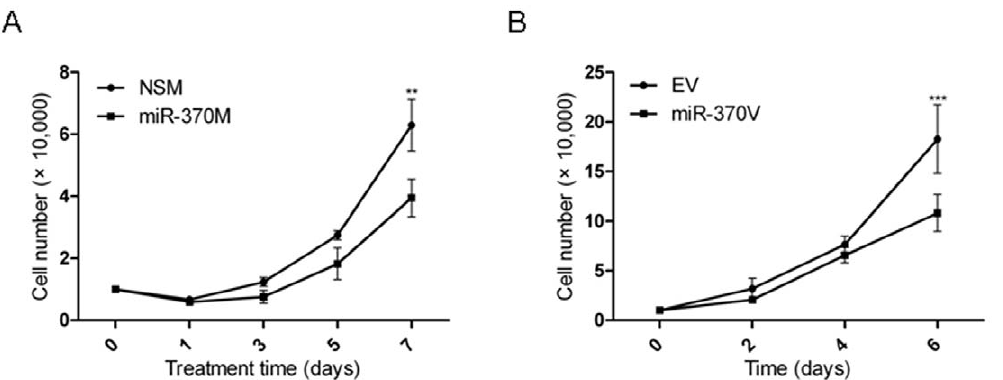
Figure 6. miR-370 induces growth retardation. A. HuCCT1 malignant cholangiocytes display decreased growth upon reinforcement of miR-370 expression. X-axis – HuCCT1 cells counted at day 1, 3, 5 and 7 after transfection with miR-370M, or NSM, respectively. Y-axis – cell counts 6 10 4 of HuCCT1 cells transfected with miR-370 mimic (miR-370M, black squares) or NSM (black circles). B. HuCCT1 malignant cholangiocytes display decreased growth upon modest miR-370 upregulation through infection with MIEG3-miR-370. X-axis – HuCCT1 cells counted at days 2, 4 and 6 after plating of MIEG3-miR-370 (miR-370V) HuCCT1 cells or MIEG3-EV (EV) HuCCT1 cells, respectively. Y-axis – cell counts 6 10 4 of miR-370V HuCCT1 cells (black circles) or the EV HuCCT1 cells (black squares). For every treatment and every time point, the data presented is the average of 5 independently counted wells. Mean 6 SD, **P , 0.01, ***P , 0.001.